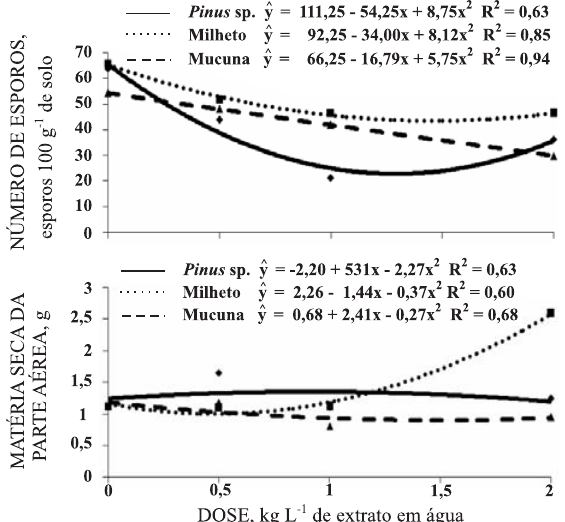
Figura 5. Número de esporos de fungos micorrízicos arbusculares e matéria seca de parte aérea em cultura de feijão em função da aplicação de quatro doses de extrato aquoso de Pinus ,